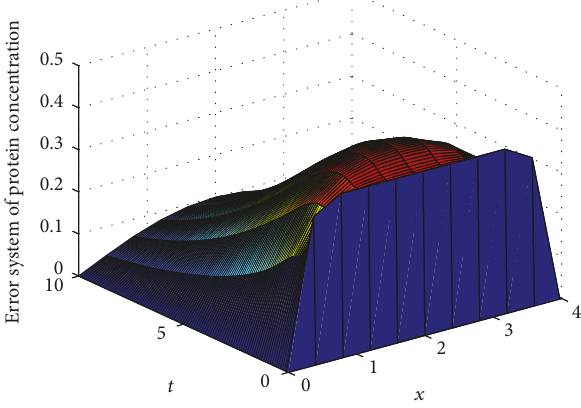
Figure 6: The protein concentrations of error system ( e